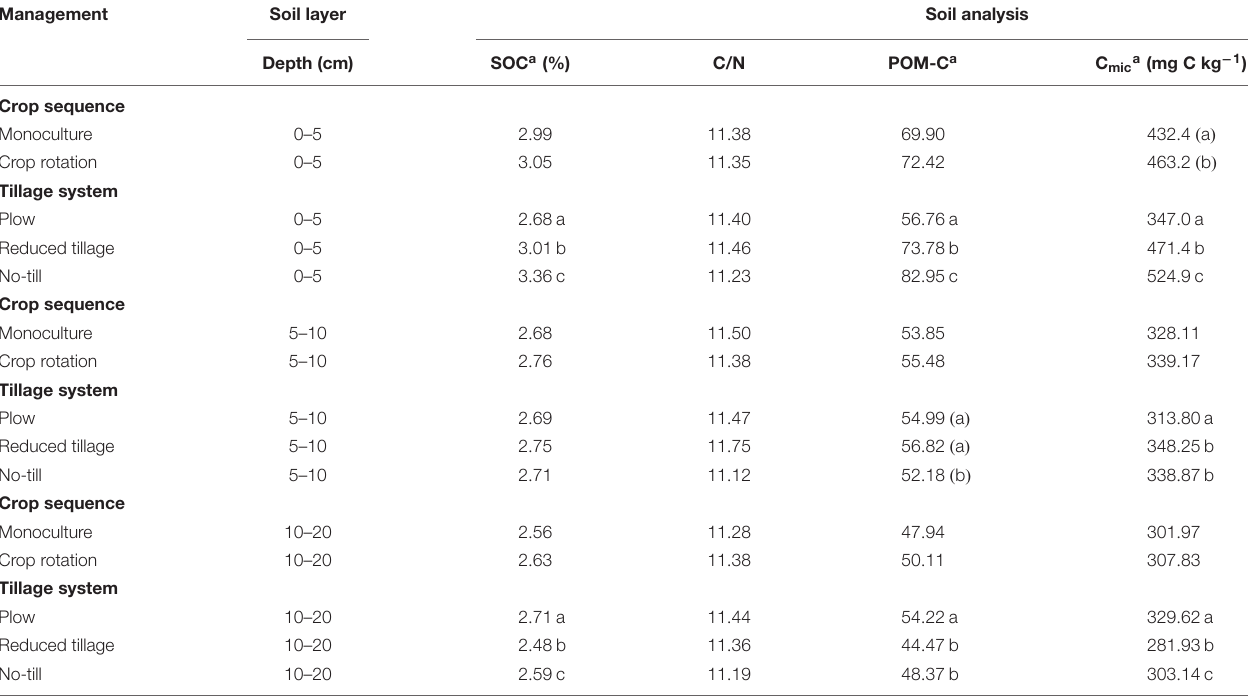
TABLE 2 | Test results of the fixed main effects in the generalized linear mixed models for soil carbon